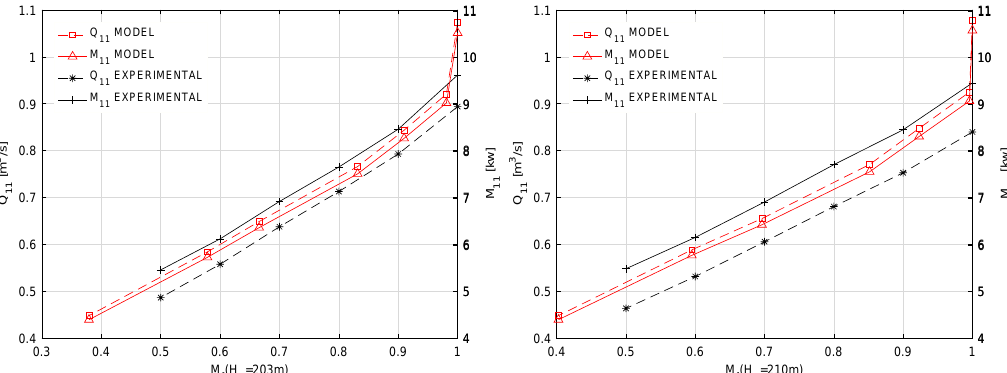
Figure 12. Comparisons of numerical and experimental data, at different heads and power factors, in turbine